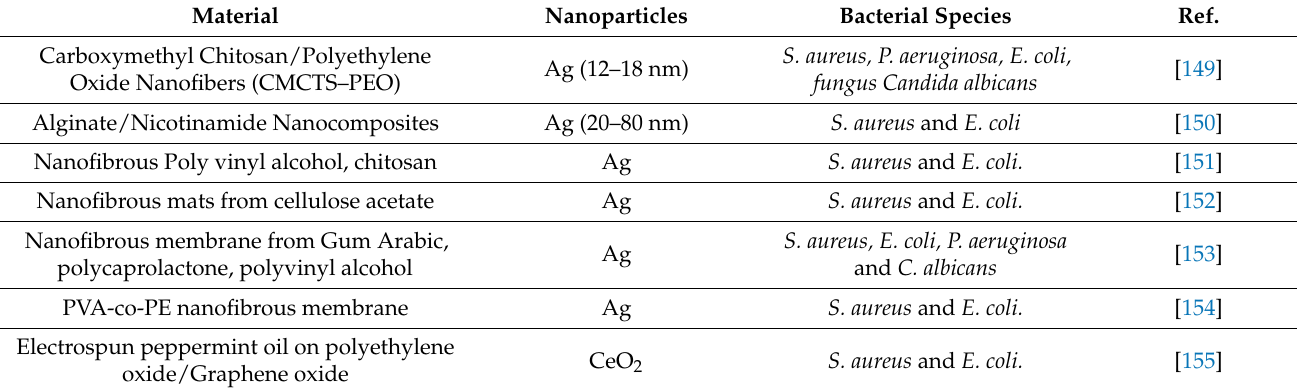
Table 4. An overview of recent wound dressing materials constructed from nanoparticles and nanomaterials. Material